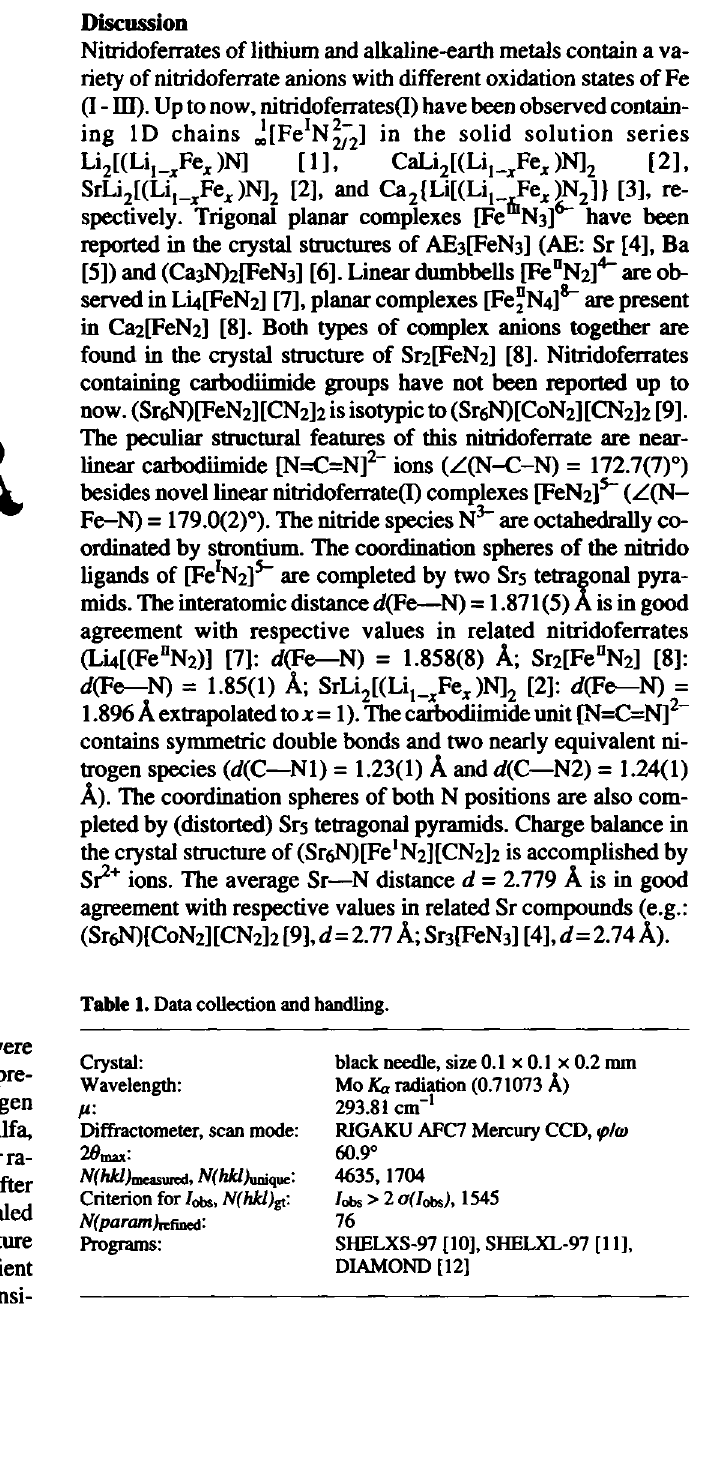
Source of material